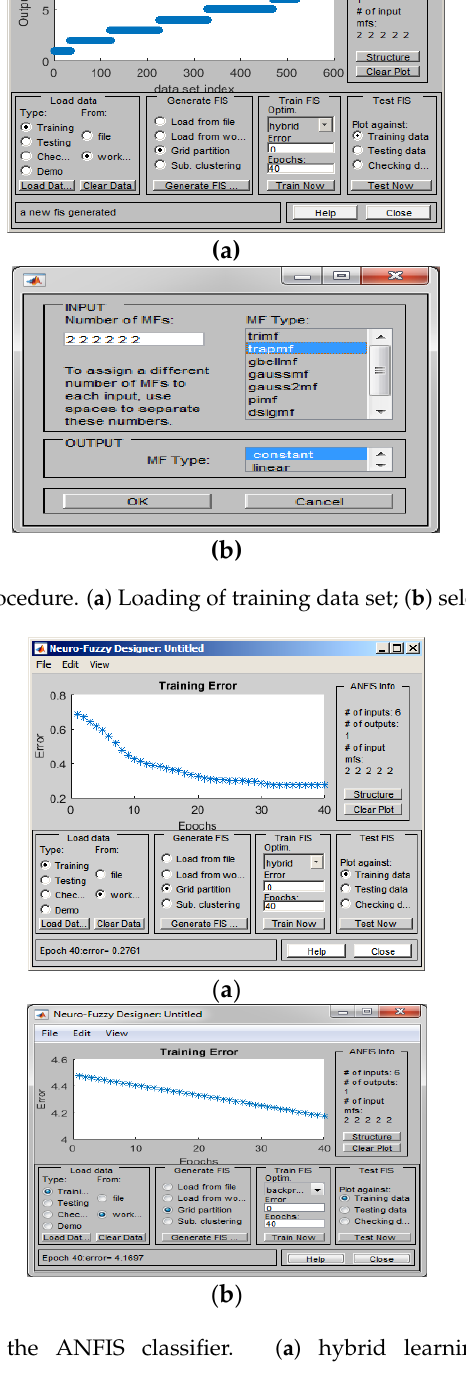
Figure 8. Training of the ANFIS classifier. ( a ) hybrid learning algorithm; ( b ) back propagation algorithm.